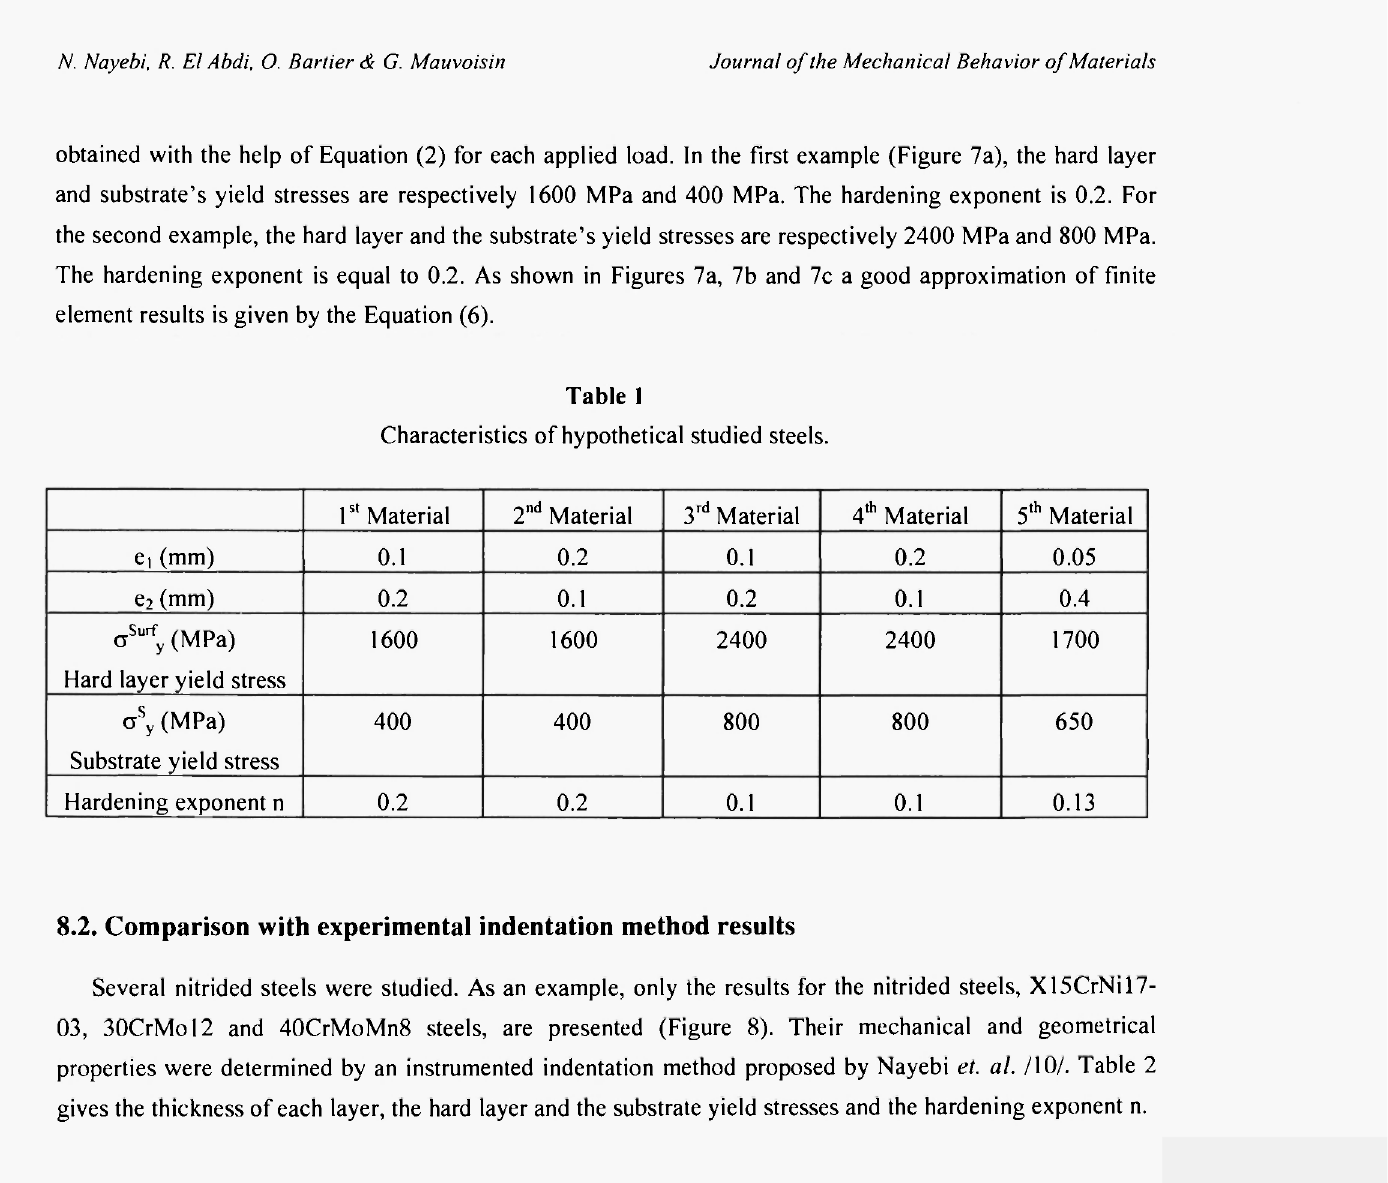
Characteristics of hypothetical studied steels.